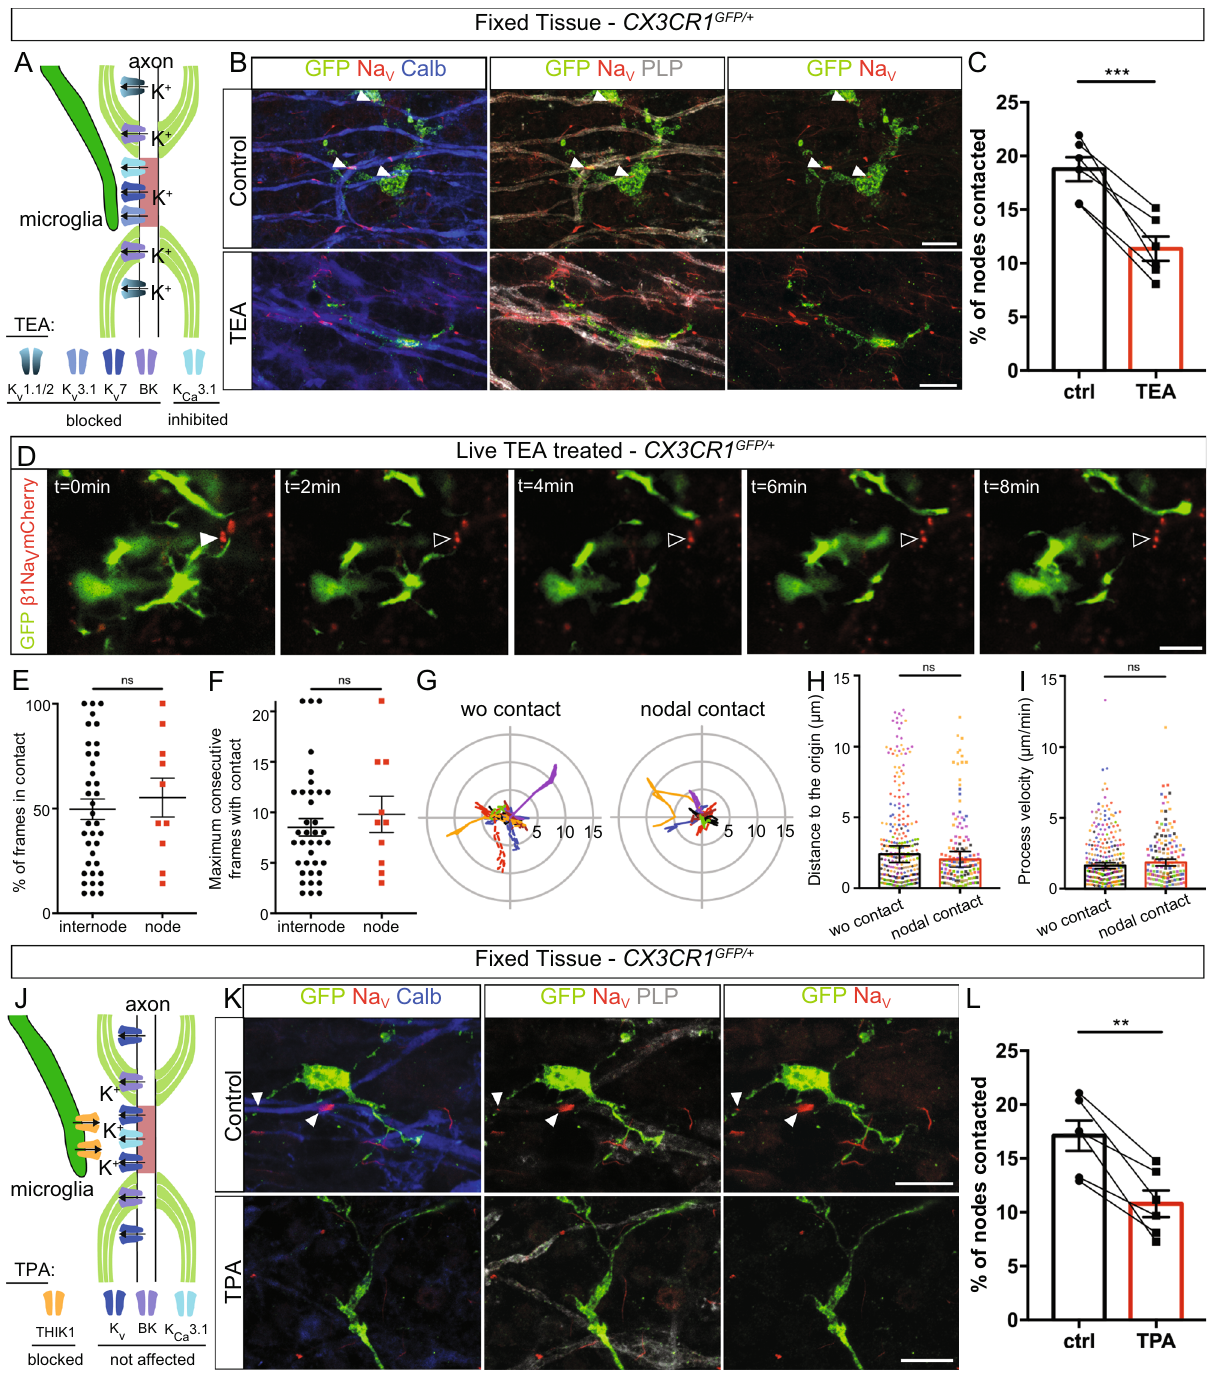
Using live-imaging we were able to demonstrate for the fi st time speci fi c interaction rather than a random survey of the local or increased local in fl ammatory signals remains uncertain. When addressing the mechanisms supporting these microglia- activity and nodal ef fl ux of potassium are playing a key role, by showing that pharmacological inhibition of nodal and perinodal potassium channels leads to a 40% decrease of the contact, and